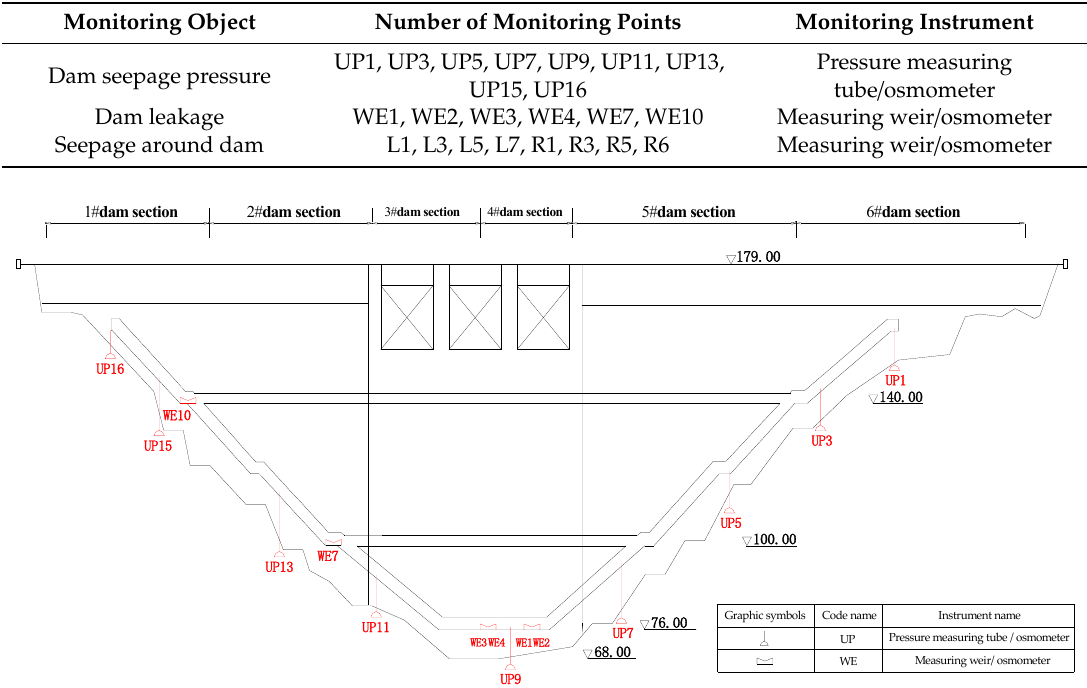
Figure 6. Location distribution map of the dam seepage monitoring points.